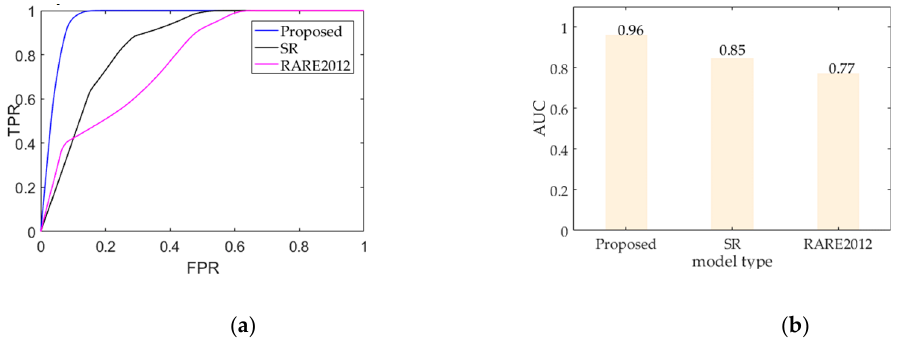
Figure 11. The receiver operating characteristic- area under the curve (ROC-AUC) performance of the saliency saliency models. ( a ) ROC curve. ( b ) AUC models. ( a ) ROC curve. ( b ) AUC value.